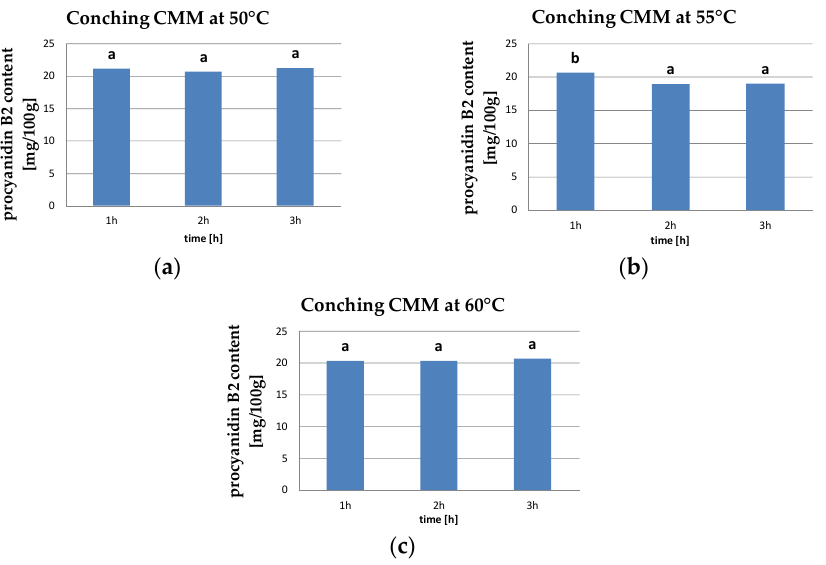
Figure 4. Procyanidin B2 content in CMM at conching temperature of ( a ) 50 °C, ( b ) 55 °C, and ( c ) 60 °C (the same letters mean that there are no statistically significant differences between the analyzed products at a confidence level of α = 0.05).